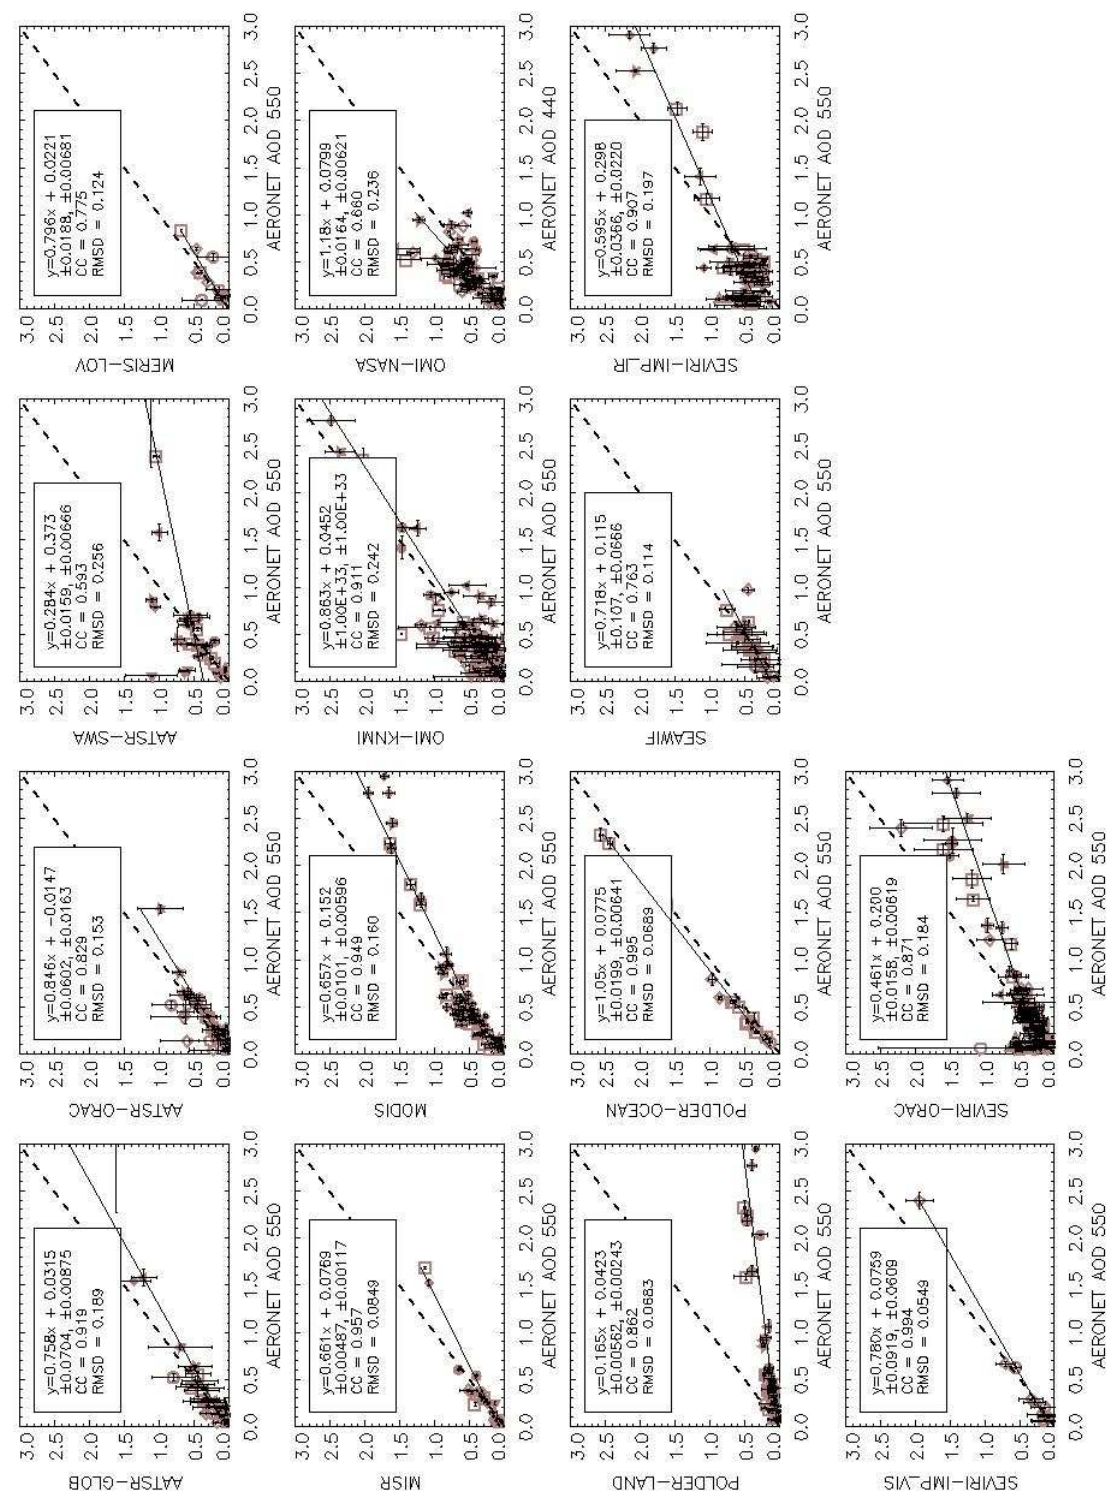
Fig. 5. Scatter plots, satellite datasets AOD (y) vs. AERONET AOD (x), for all the available coincidences. Different locations are represented by different symbols, as defined in Fig. 3. In every scatter plot, there are captions indicating the best linear fit (angular coefficients, y intercept and associated errors), the correlation coefficient (CC) and the root-mean-square differences (RMSD).